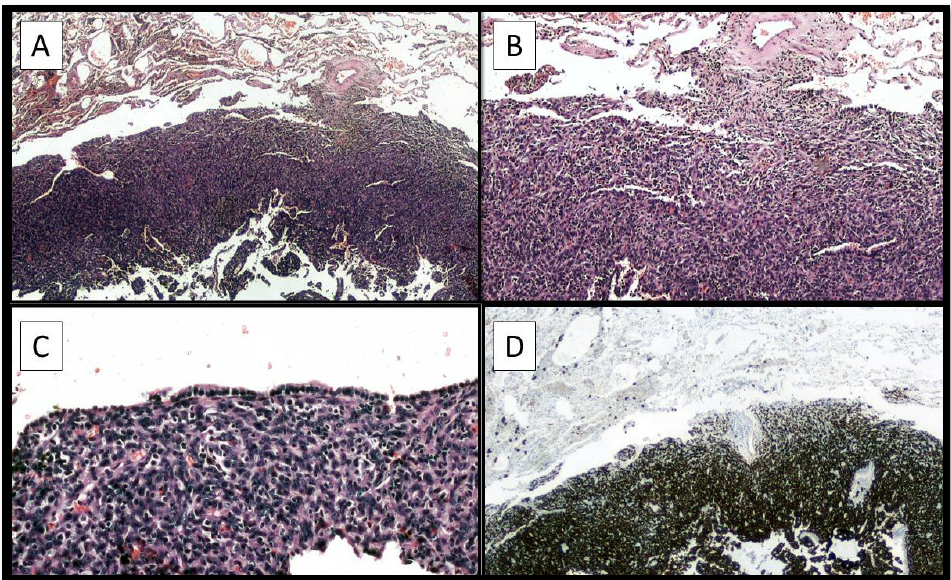
Figure 3. ( A , B ) The histological analysis highlighted a lesion with morphological characteristics very similar to the previous AFH, although the organ location had changed. In ( C ) was possible to appreciate the respiratory mucosa that covers a part of AFH. Immunohistochemical investigations were again conducted which were positive for Desmin ( D ), CD68, with a Ki67 + of about 10 – 15%. A diagnosis of metastasis in the upper lobe of the right lung of AFH was made and the sample was sent for FISH investigation for diagnostic confirmation. Molecular analyzes revealed the presence of the EWSR1::CREB1 fusion gene. This feature was very important to confirm and start the thera- peutic path [1 – 3]. Regarding the differential diagnosis, it is important to differentiate AFH from other types of dermatofibroma, or, in the case of prominent myxoid change, from other myxoid tumors such as low-grade fibromyxoid sarcoma, extraskeletal myxoid chondrosarcoma and myxoid liposarcoma [4]. The case presented is of particular interest for three reasons: (1) AFH metastasis rate described in the literature is around 1 – 5%, with about 15 cases of AFH lung involvement de- scribed [5,6]; (2) from the few published cases of metastatic AFH, it would seem that the presence of the EWSR1::CREB1 fusion gene predisposes more aggressive behavior of the neoplasm [7]; care- ful follow-up with the possibility of performing a FISH in cases of relapsed AFH is mandatory [1,2,8 – 12].